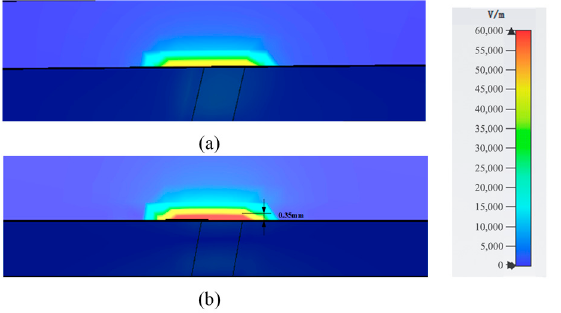
Figure 7. Electric field distribution of the cut-plane of one way in the central-flat structures: ( a ) the basic structure and ( b ) the AGA-optimized structure.